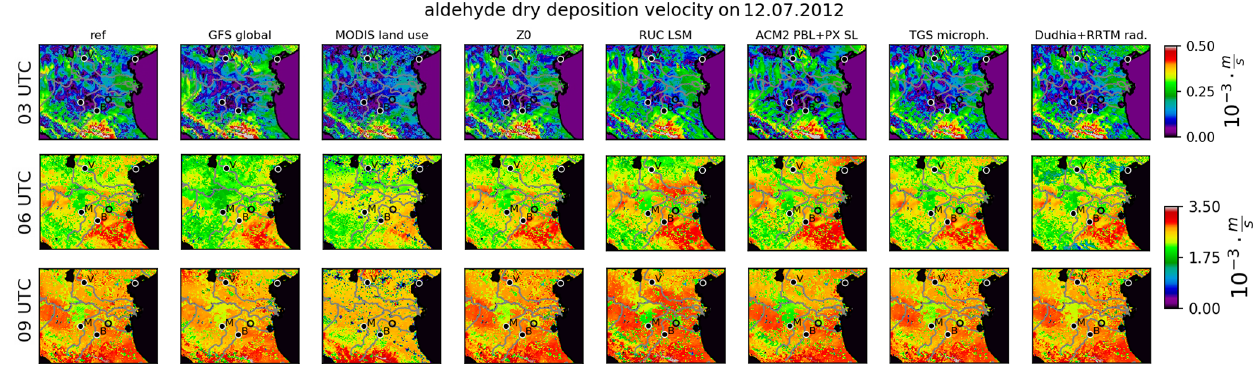
Figure 4. Dry deposition velocities of aldehyde on 12 July 2012 at 03:00, 06:00 and 09:00UTC (coded by color) for different model configurations, including increased roughness length (“ Z 0”). Plotting conventions are like in Fig.